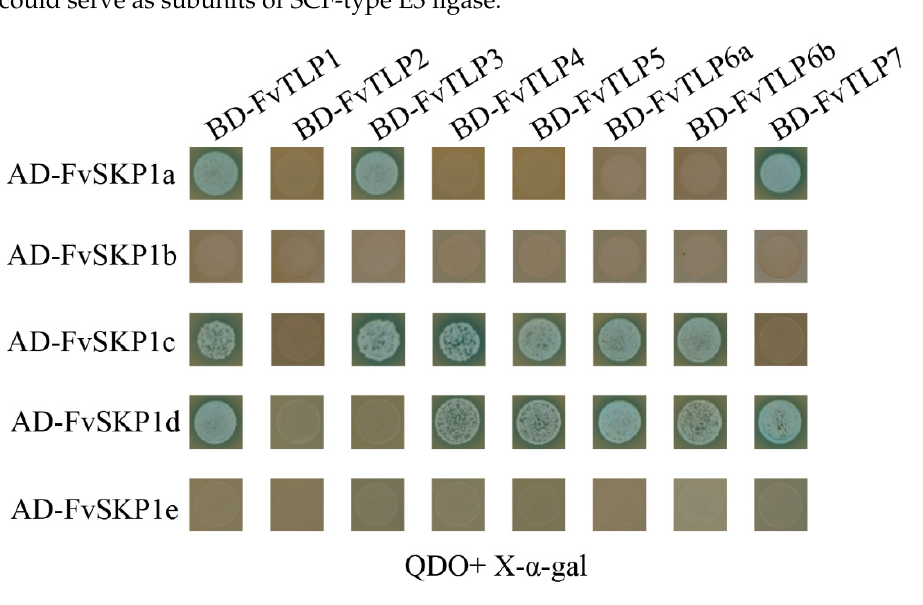
Figure 5. Transcriptional activity analyses of FvTLPs by yeast one ‐ hybrid assays. Yeast cells trans ‐ formed with the empty vector pGBKT7 (negative control, NC), pGBKT7 ‐ CsTLP8 (positive control, PC), or pGBKT7 ‐ FvTLP s were streaked on SD/ ‐ Trp/ ‐ His/X ‐α‐ gal medium.